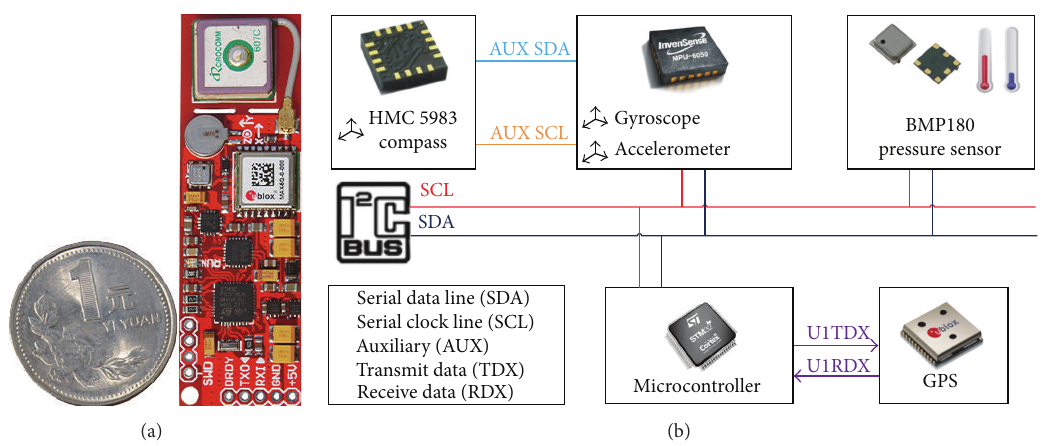
Figure 2: Attitude Heading Reference System. (a) Printed Board Layout (b) detailed